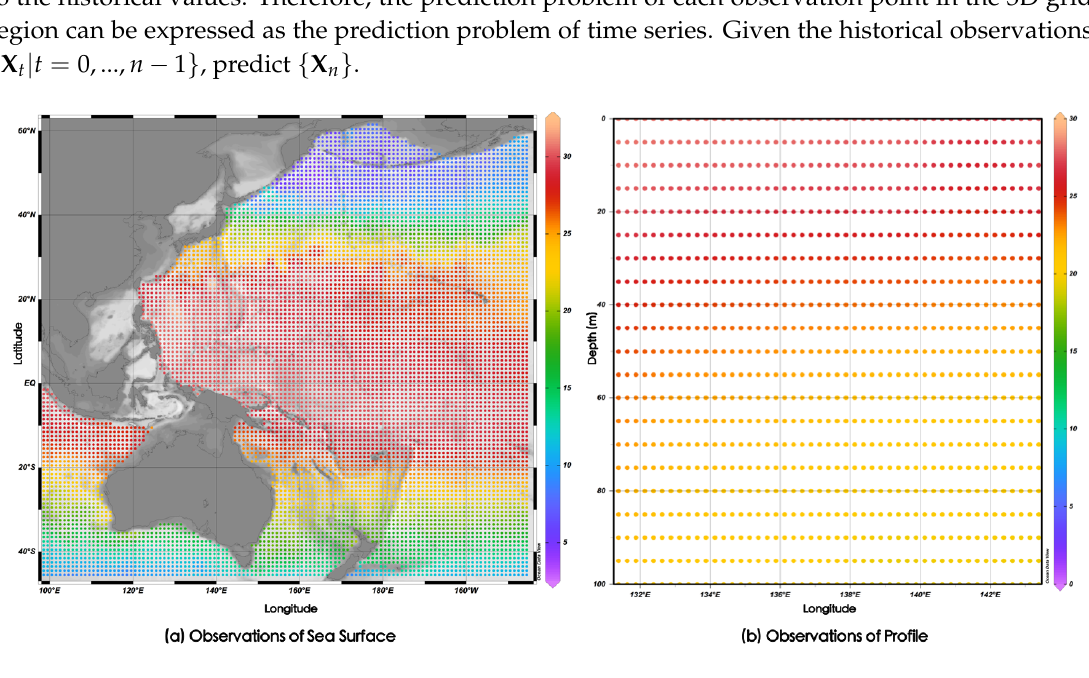
Figure 1. Grid data of ocean